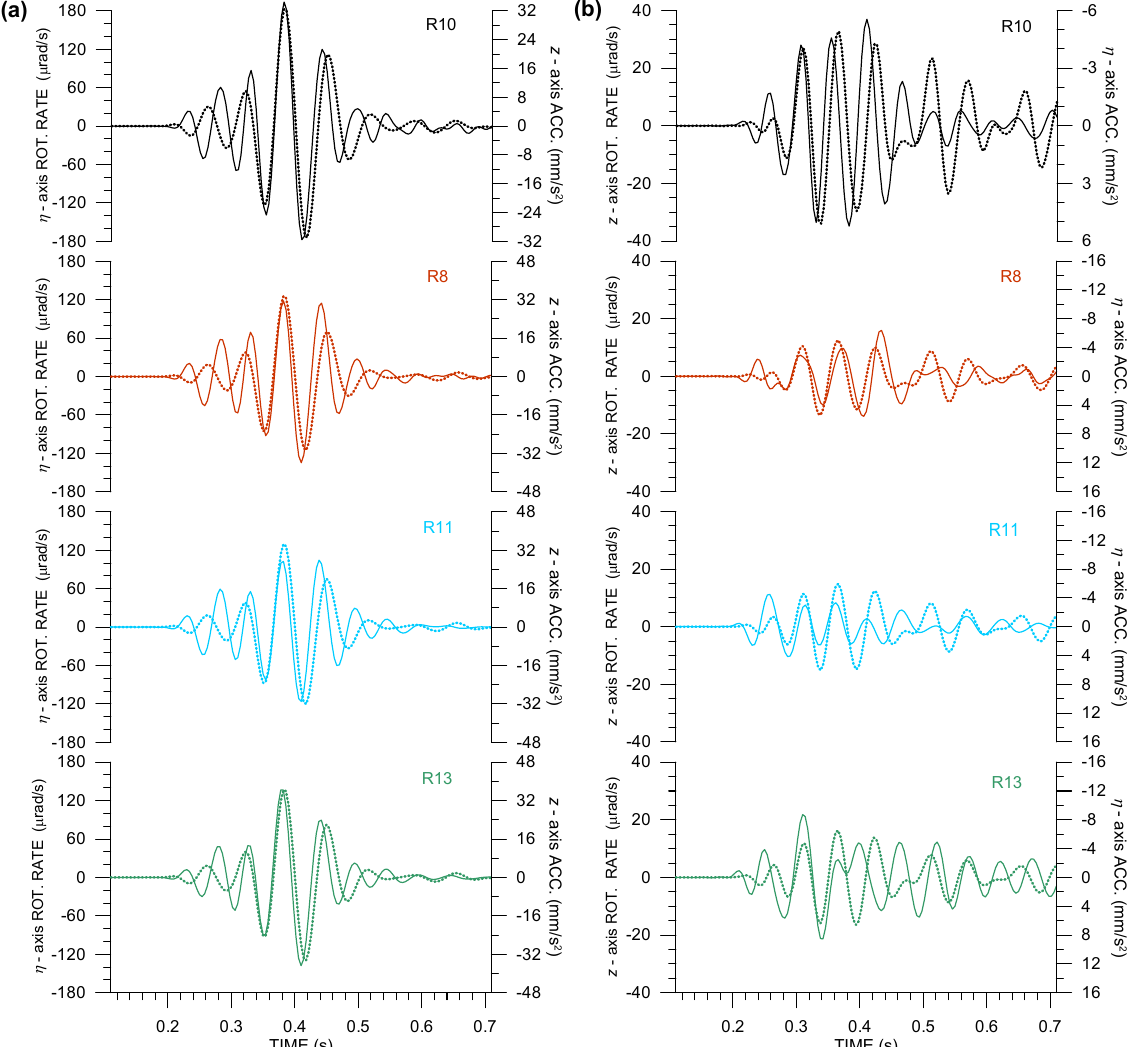
Figure 5. Waveform matching of the relevant rotation rate (solid) and ground acceleration (dotted) components in records of Expl2 in the huddle test from four 6C Rotaphone-CY instruments (R8—red, R10—black, R11—light blue, and R13—green): rotation rates around the transverse axis and vertical ground acceleration ( a ), and rotation rates around the vertical axis and transverse ground acceleration ( b ). The transverse axis is perpendicular to the geometrical azimuth of 305.6 ◦